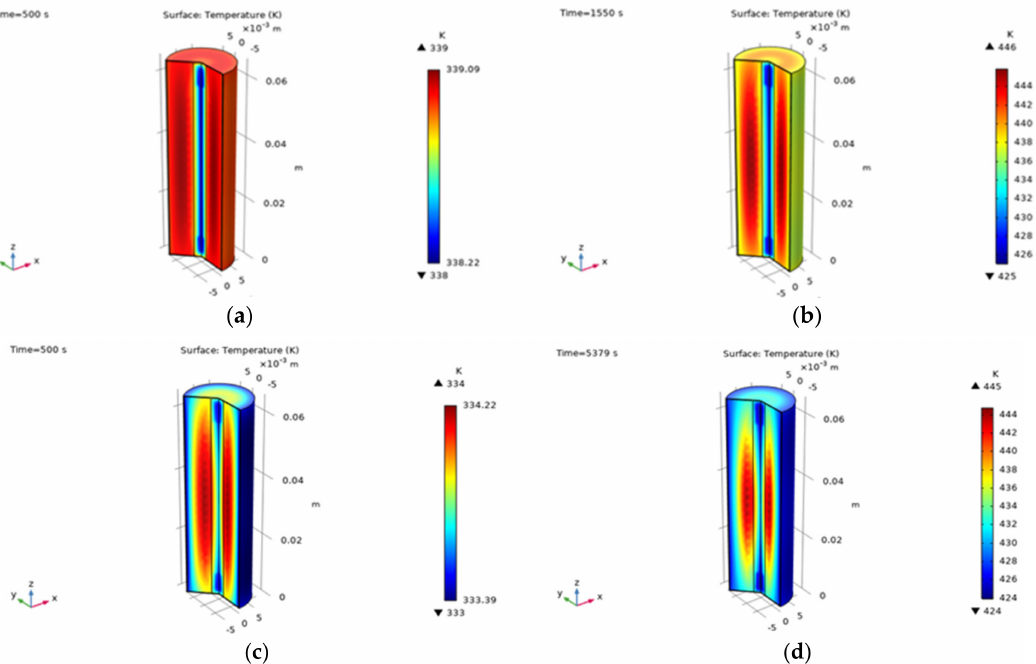
Figure 16. Thermal distribution inside an LCO cathode cell: ( a ) after one complete charge–discharge cycle, h = 0 W/m 2 K; ( b ) at the thermal runaway ignition time, h = 0 W/m 2 K; ( c ) after one complete charge–discharge cycle, h = 10 W/m 2 K; and ( d ) at the thermal runaway ignition time, h = 10 W/m 2 K. Initial T = 313